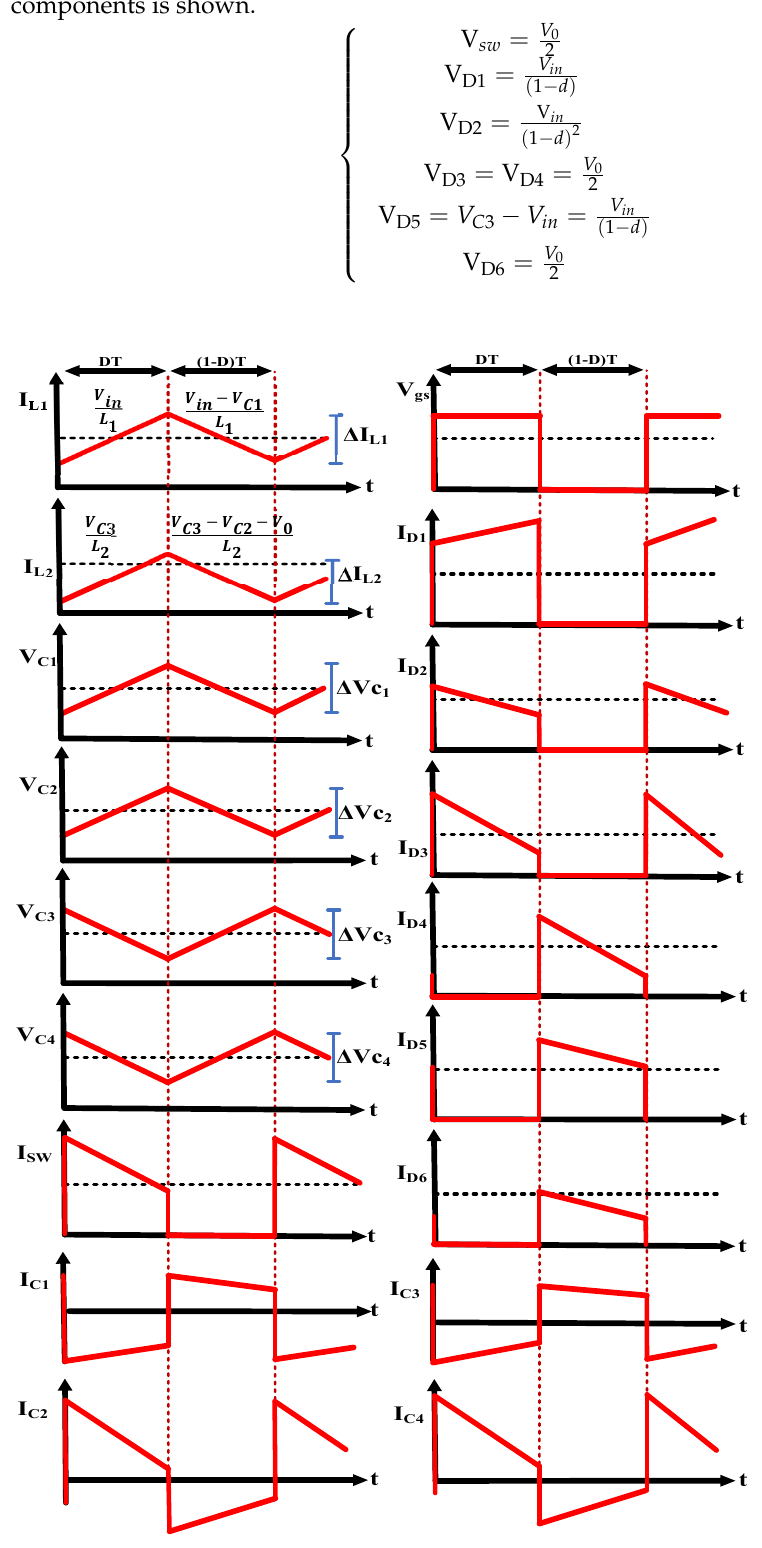
Figure 9. The corresponding steady-state waveform of CCM mode.